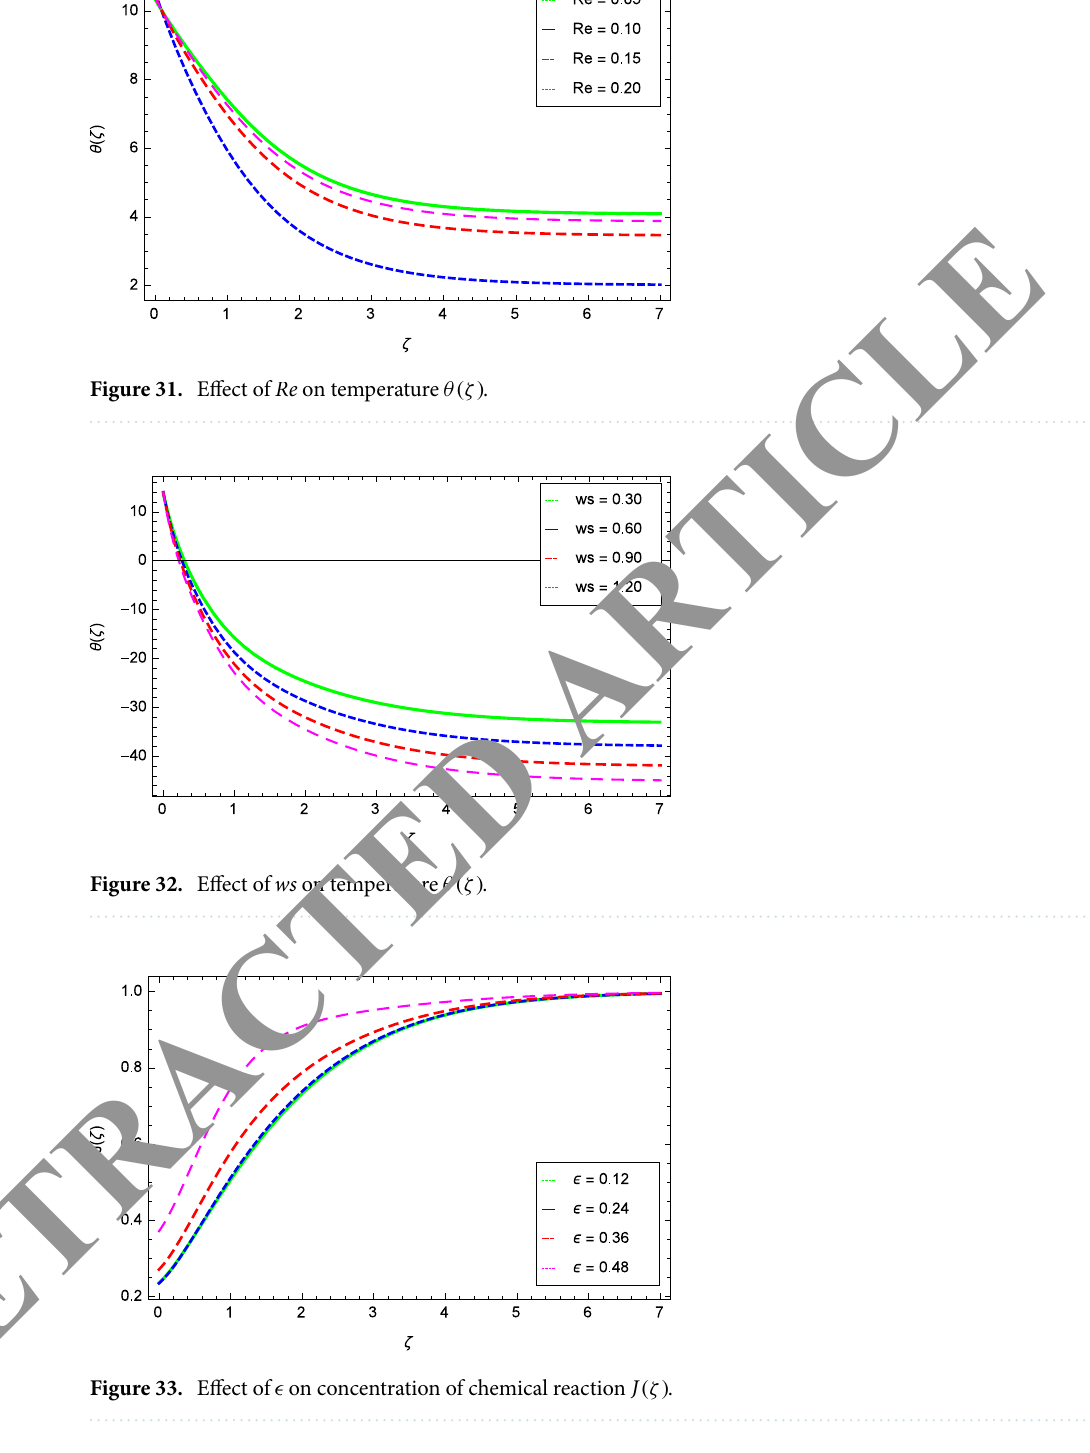
Figure 33. Effect of ǫ on concentration of chemical reaction J (ζ) .